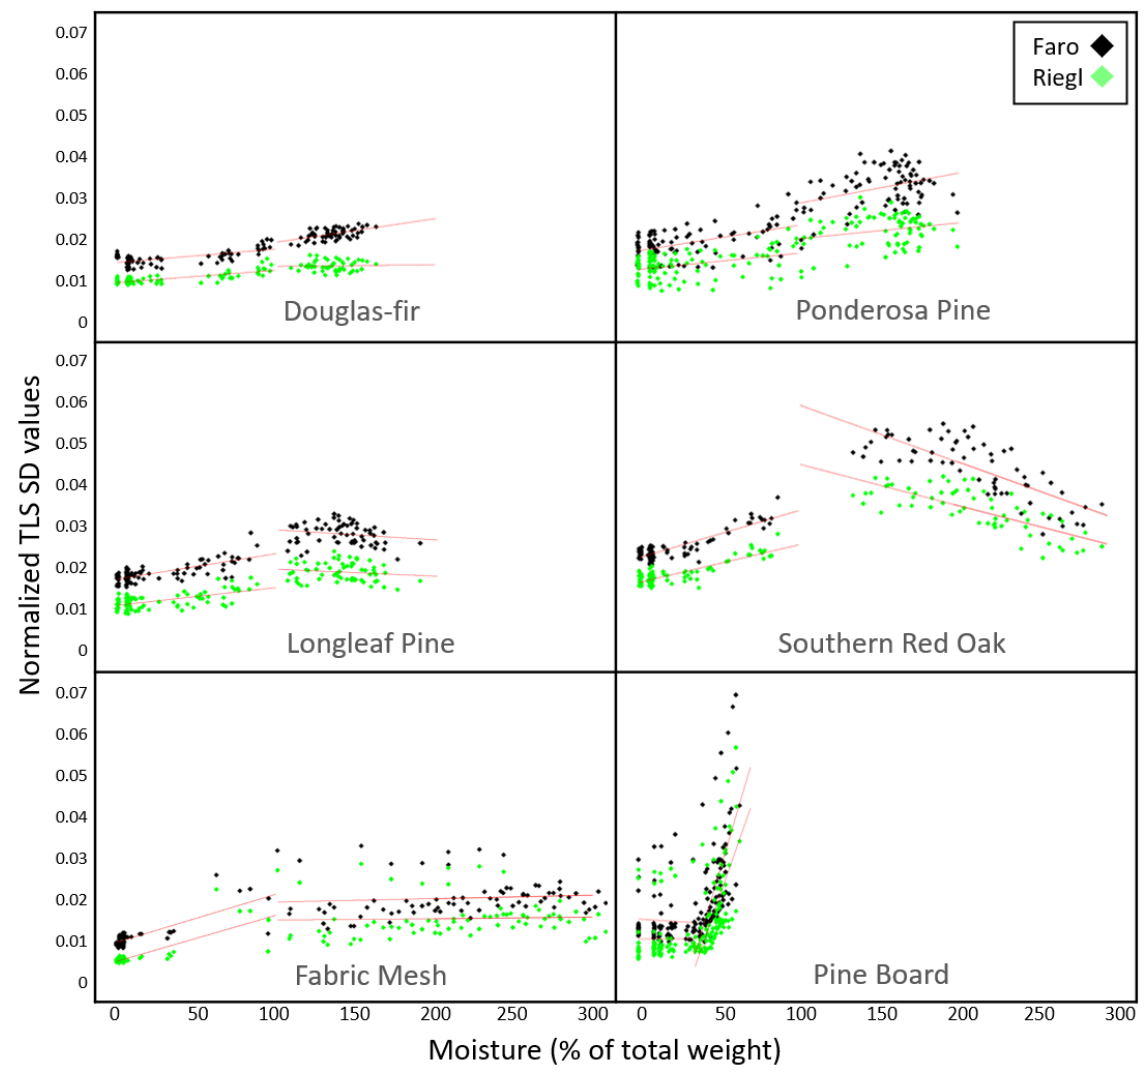
Figure 8. Standard deviation of normalized intensity values of the samples placed at 3 m from the FARO and RIEGL scanners. Regression lines from a broken stick linear regression model are added. The break location was 100% for all sample materials except pine board for which the break was located at 40%.